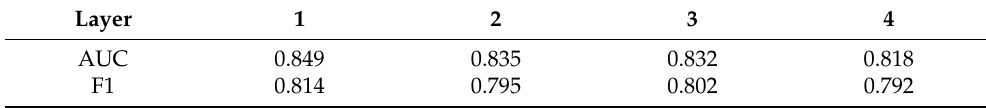
Table 11. The Influence of depth of layer on Last.FM.